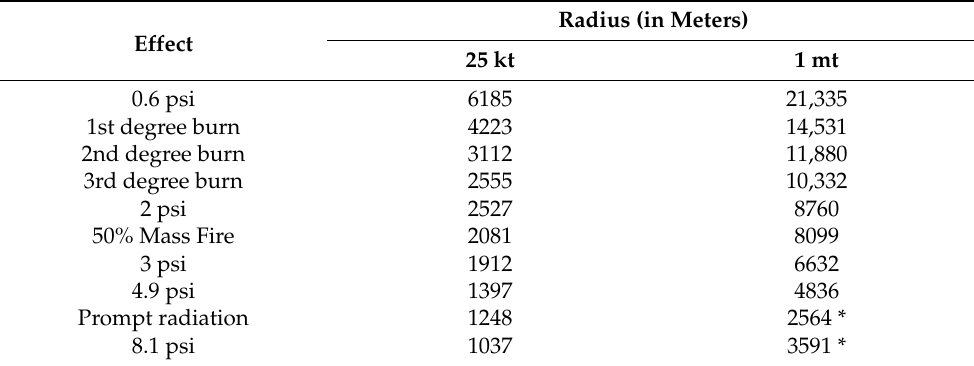
Table 1. Radii of effect circles for 25 kt and 1 mt